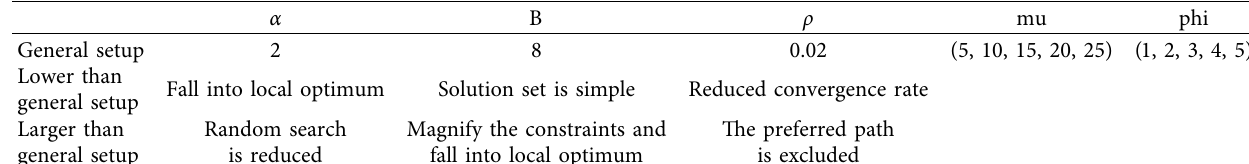
Table 1: α , β , ρ , mu, and phi fve parameter details.